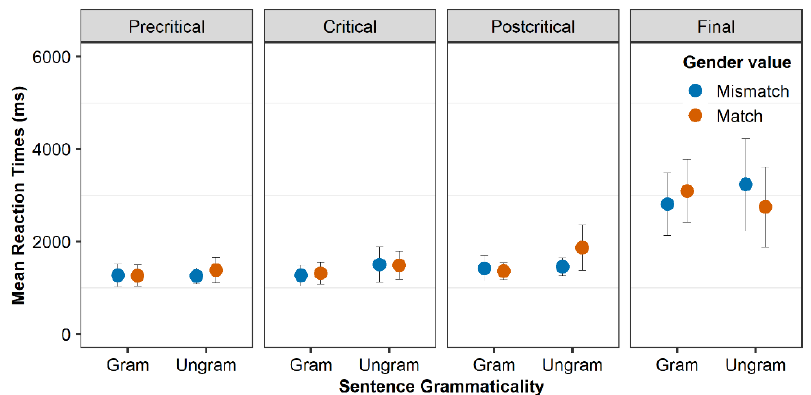
Figure 6. RTs of the 2L1 group excluding the children for which MG was not the dominant language per segment.